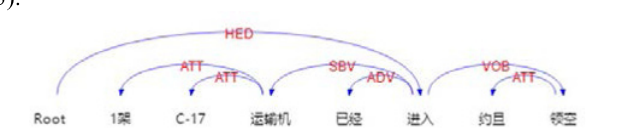
Fig. 2. A Chinese sentence example of dependency parsing.